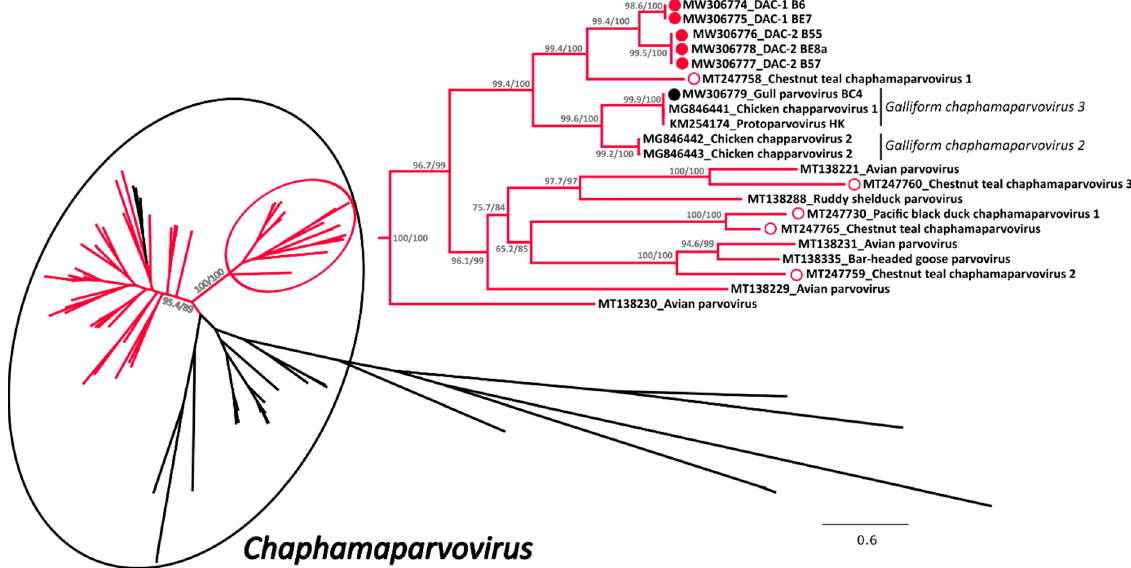
Figure 2. Phylogenetic analysis of the duck associated chapparvoviruses (DAC) within the Hamaparvovirinae . The phylogenetic tree based on 101 full NS1 protein sequences was built with the maximum-likelihood method based on the General matrix (LG) + F + R6 model with IQ-Tree [31]. The outcomes of the SH-aLRT and bootstrap test are shown for the main nodes. The branches of the unrooted tree are color-coded based on the host in which viruses have been identified and red represents avian hosts, while black includes all other vertebrate and invertebrate hosts. The black circle indicates viruses within the genus Chaphamaparvovirus while the red circle shows the clade containing the viruses studied here, which is also shown enlarged on the right side. The viruses identified in this study are labelled with a colored full circle (red for those found in ducks and black for the one found in a gull), while viruses found by others in ducks (genus Anas ) are indicated by an empty red circle. Species designations, when available, are indicated on the right.